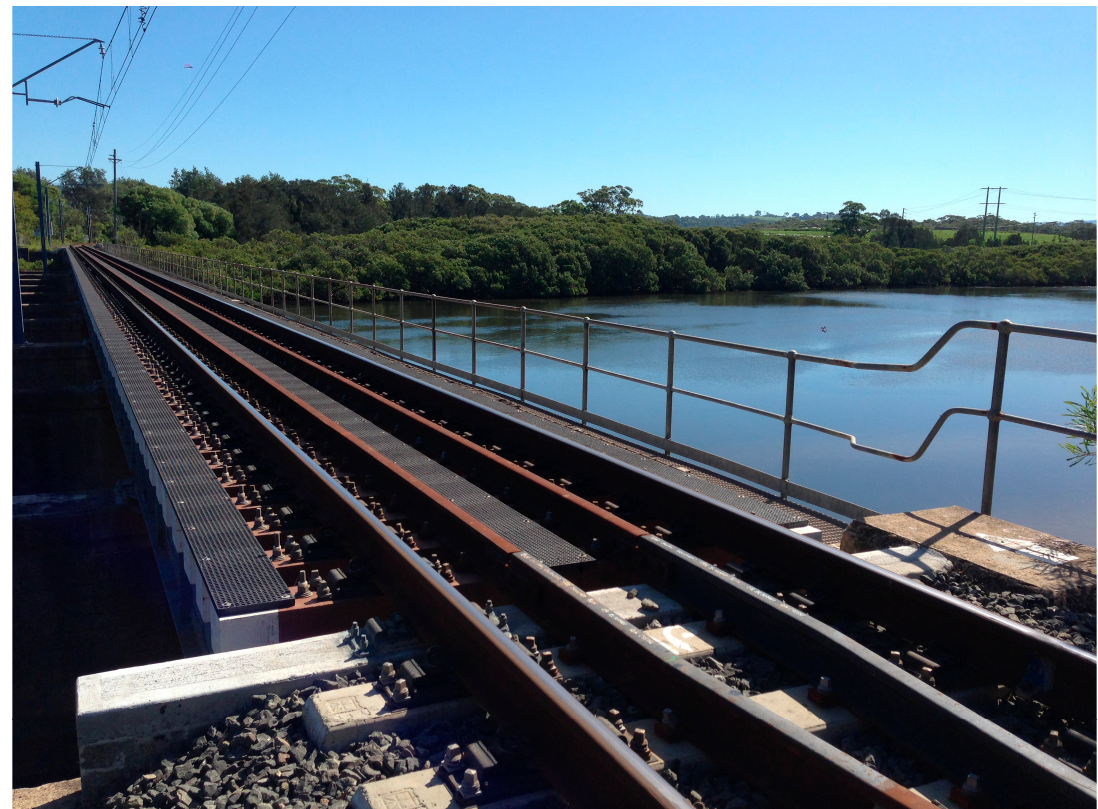
Figure 1. The Minnamurra Railway Bridge in New South Wales, Australia.